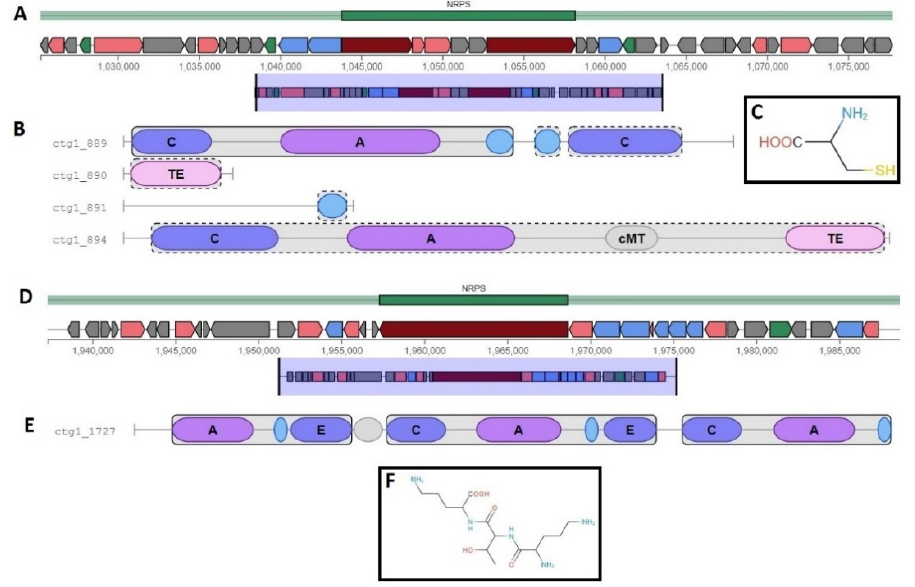
Figure 8. D. congolensis NRPS gene clusters, domain arrangements, and predicted core structure of products. Gene clusters, domains, and prediction of core structures were performed in antiSMASH [23]. ( A ) NPRS gene cluster containing two core biosynthetic and two additional biosynthetic genes. This cluster also contained other genes. ( B ) domain arrangement details C = Heterocyclization; A = AMP-binding with substrate prediction at consensus cys; cMT = Carbon methyltransferase; TE = Thioesterase. ( C ) the predicted core structure of the product molecule. ( D ) NPRS gene cluster containing a single gene. ( E ) domain arrangement; A = AMP-binding with substrate prediction consensus at orn; E = epimerization; C = condensation_DCL; A = AMP-binding with substrate prediction consensus at thr; E = epimerization; C = condensation_DCL; AMP-binding with substrate prediction consensus at orn. ( F ) predicted core structure of the product molecule.